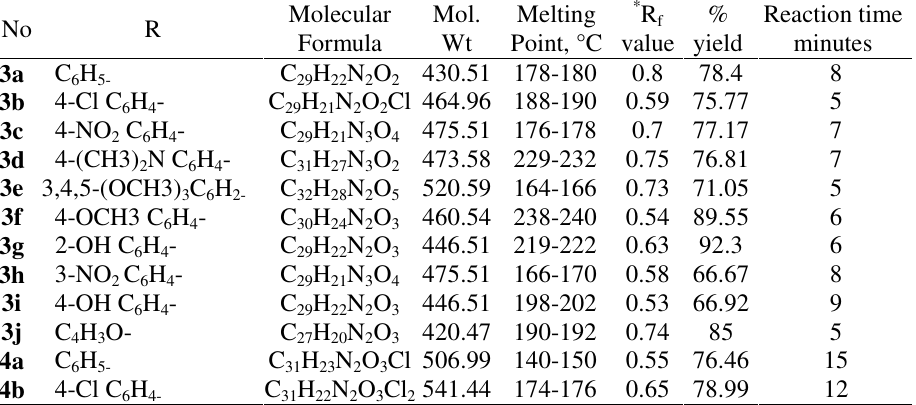
Table 2. Physical data of synthesized